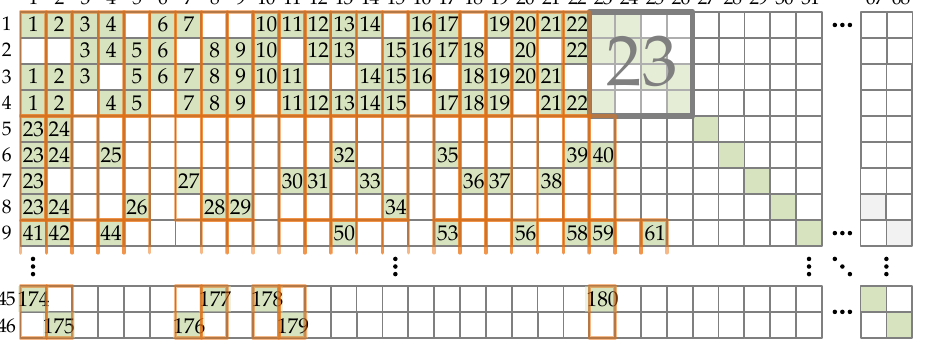
Figure 5. Proposed encoding schedule for BG1 codes when four CSs are available. Numbers represent the ordinal of the clock cycle in which the corresponding CPM is processed.